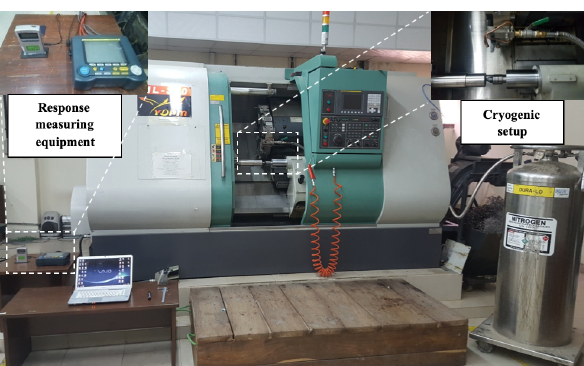
Figure 1. Experimental setup with add-on cryogenic apparatus. Table 2. Chemical Composition (wt%) of Ti-6Al-4V.